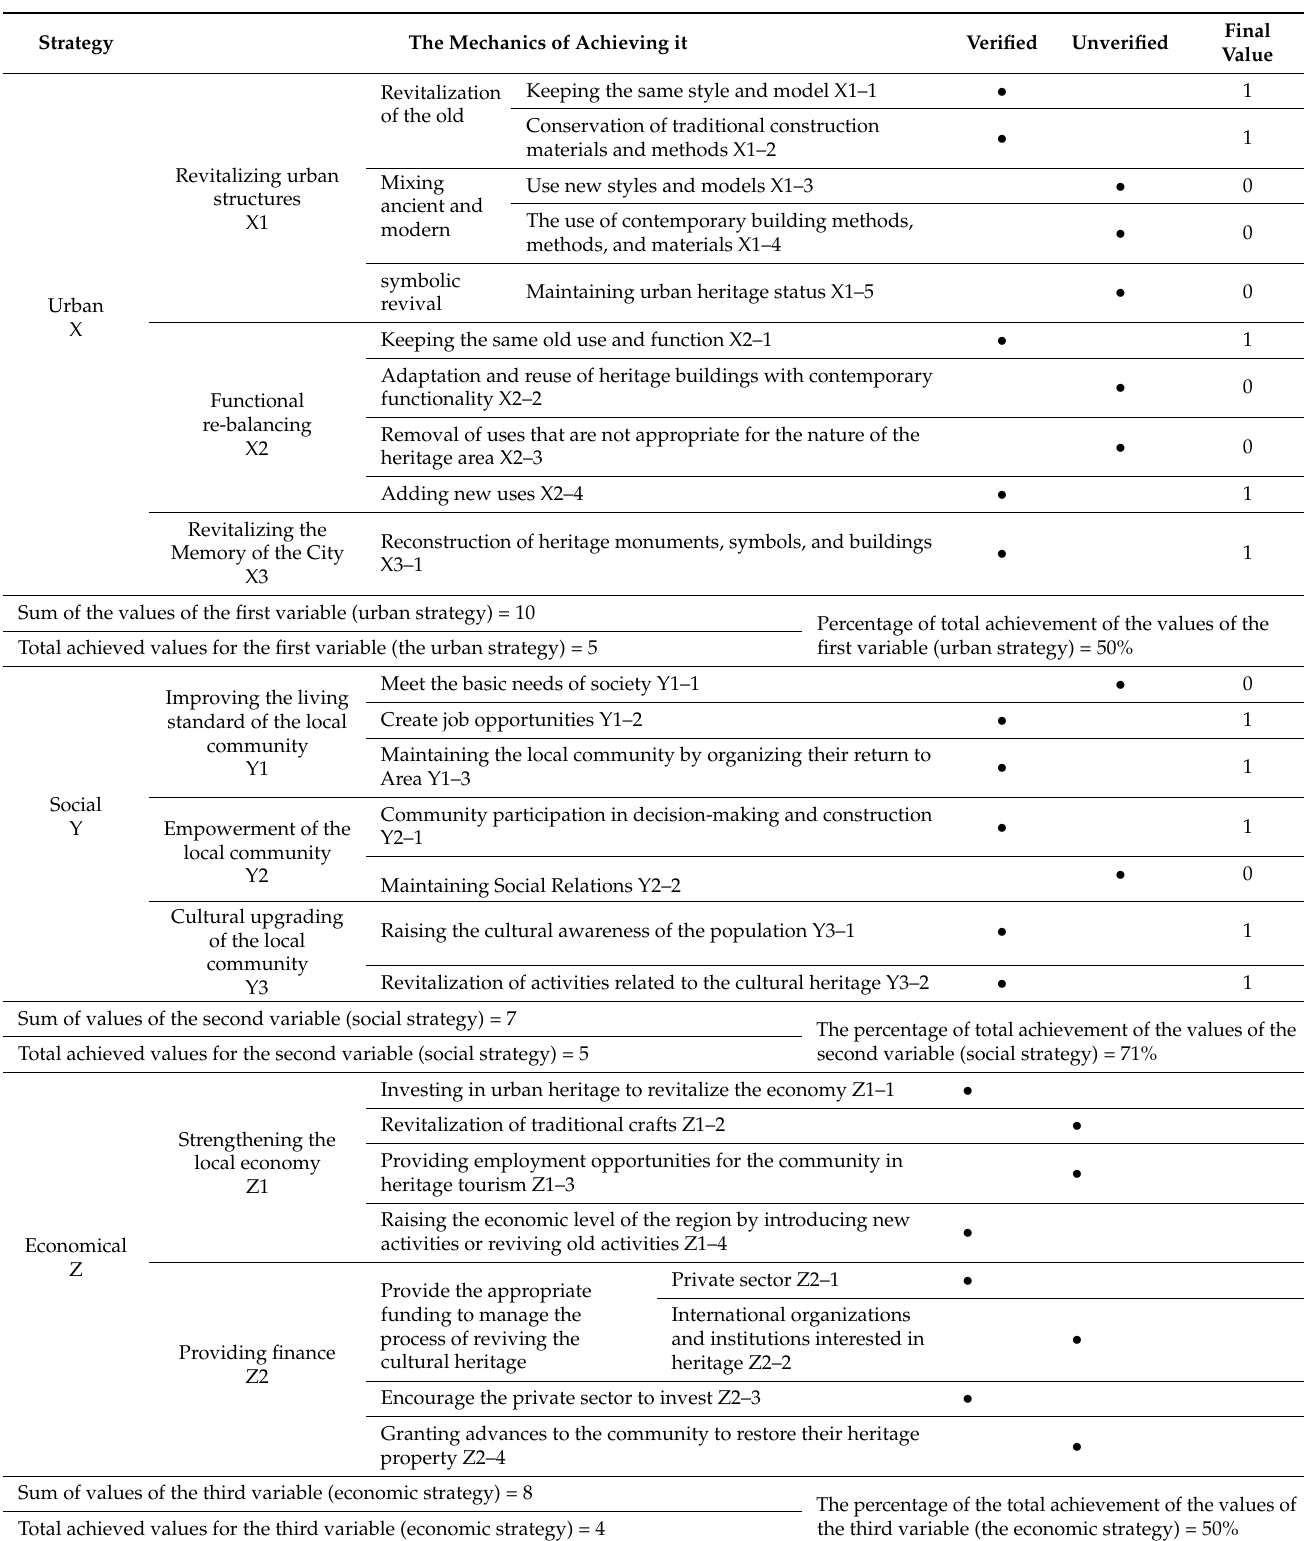
Table 5. The most important indicators extracted for the revival of cultural heritage after war. Project